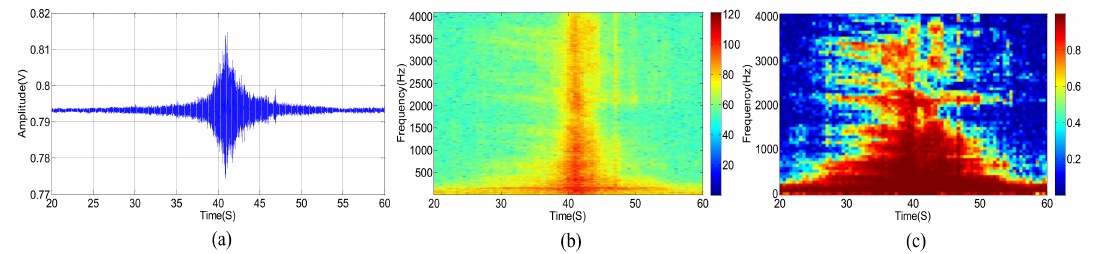
Figure 3. ( a ) Acoustic signal of a vehicle without wind. ( b ) Power spectrum of a vehicle without wind. ( c ) SMSC of the vehicle’s power spectrum without wind.